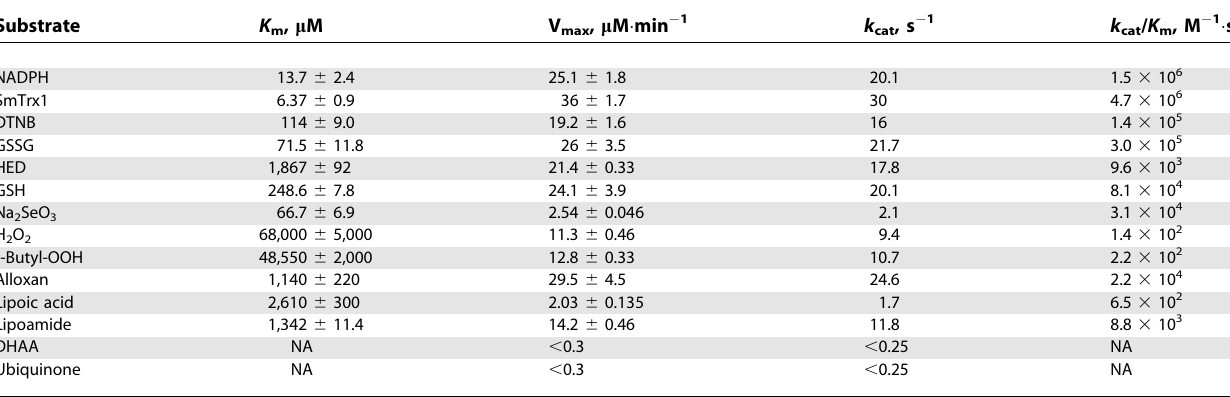
Table 1. Kinetics of Recombinant S. mansoni TGR with Different Substrates Substrate